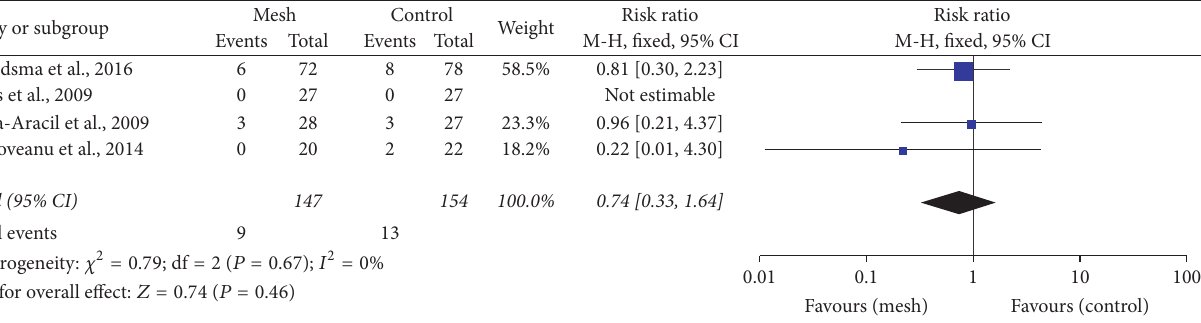
Figure 6: Forest plot for wound infection.